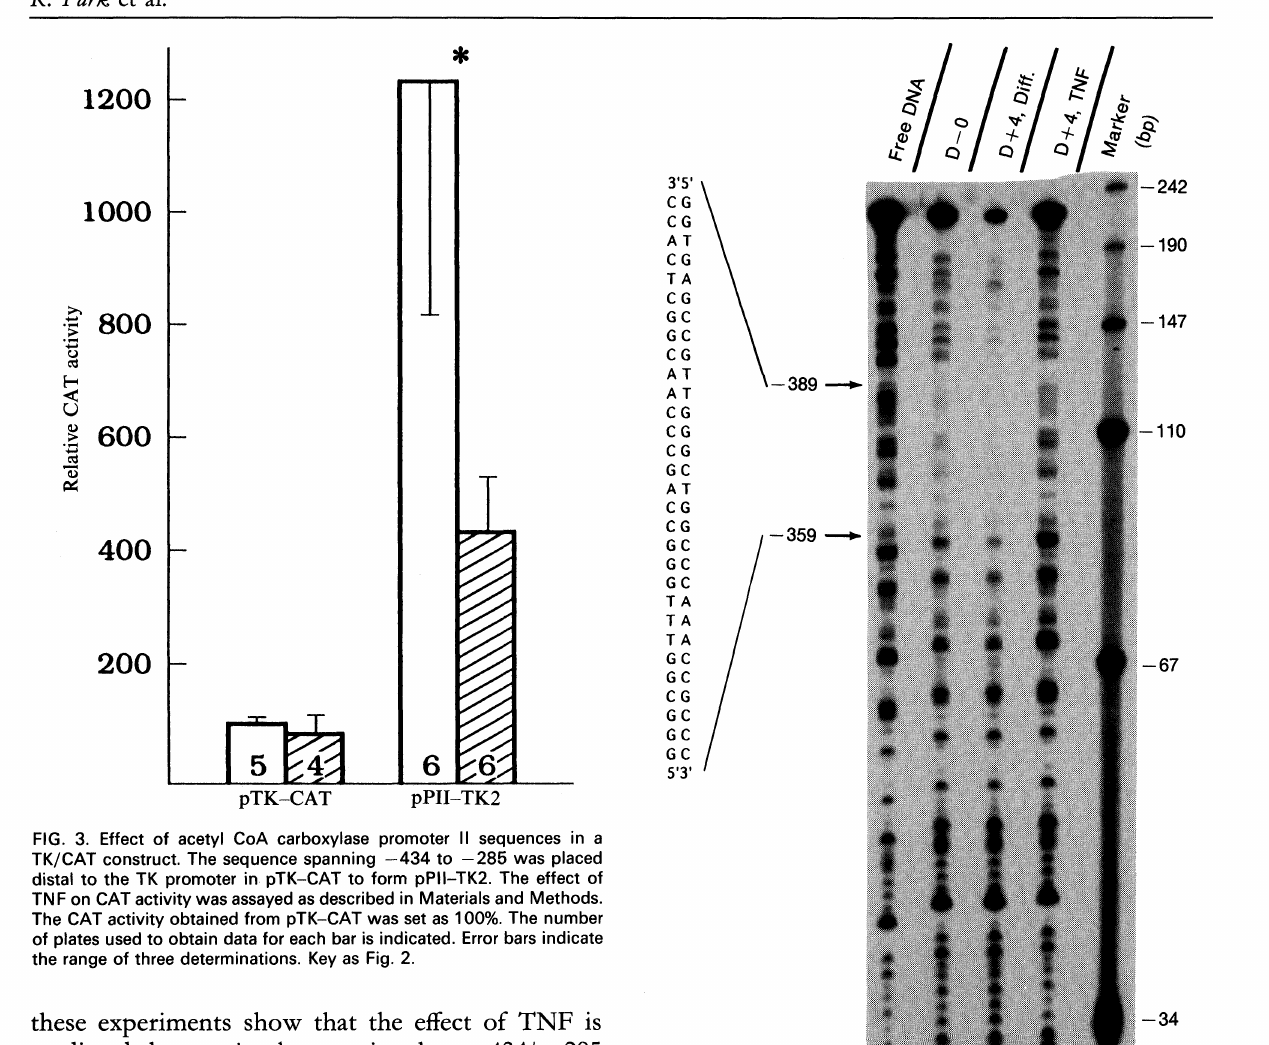
FIG. 4. DNase footprinting analysis of DNA-protein interactions at ACC promoter I1. Footprinting analysis was performed with the -434 to -285 fragment of pPII-TK2 construct labelled in the non-sense strand (lanes to 4). The probes were incubated with nuclear extracts (40 #g) from 30A5 preadipocytes at confluency (lane 2) or the fully differentiated adipocytes at day +4 (lane 3) or TNF treated cells at day +4 (lane 4). These binding mixtures were then subjected to DNase (0.5 U/2 #1 for lane 1, 5U/2#1 for lanes 2 through 4) treatment for 2 min at room temperature as described in Materials and Methods. Lane indicates the free probe DNA. Lane m represents the molecular weight markers r,-32p] end labelled Hpall fragments of pUC 19) whose lengths in nucleotides are indicated to the right. The protected regions are indicated by arrows and the numbers correspond to the position of the nucleotides relative to the transcription initiation site. The protected sequences of the ACC PII promoter are shown in the